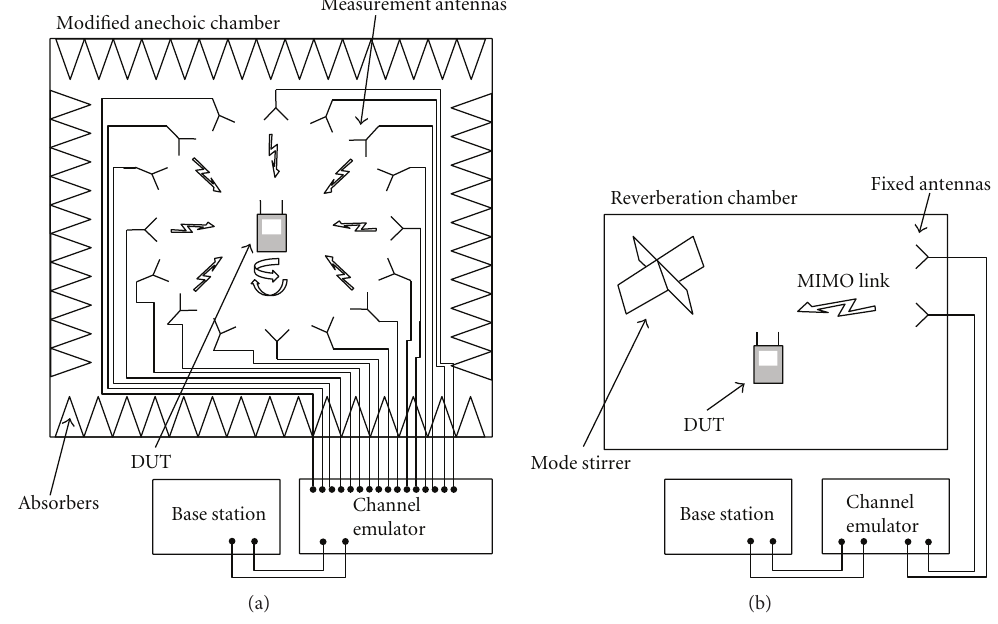
F 9: Example measurement setups for active MIMO testing of antennas for wireless handheld